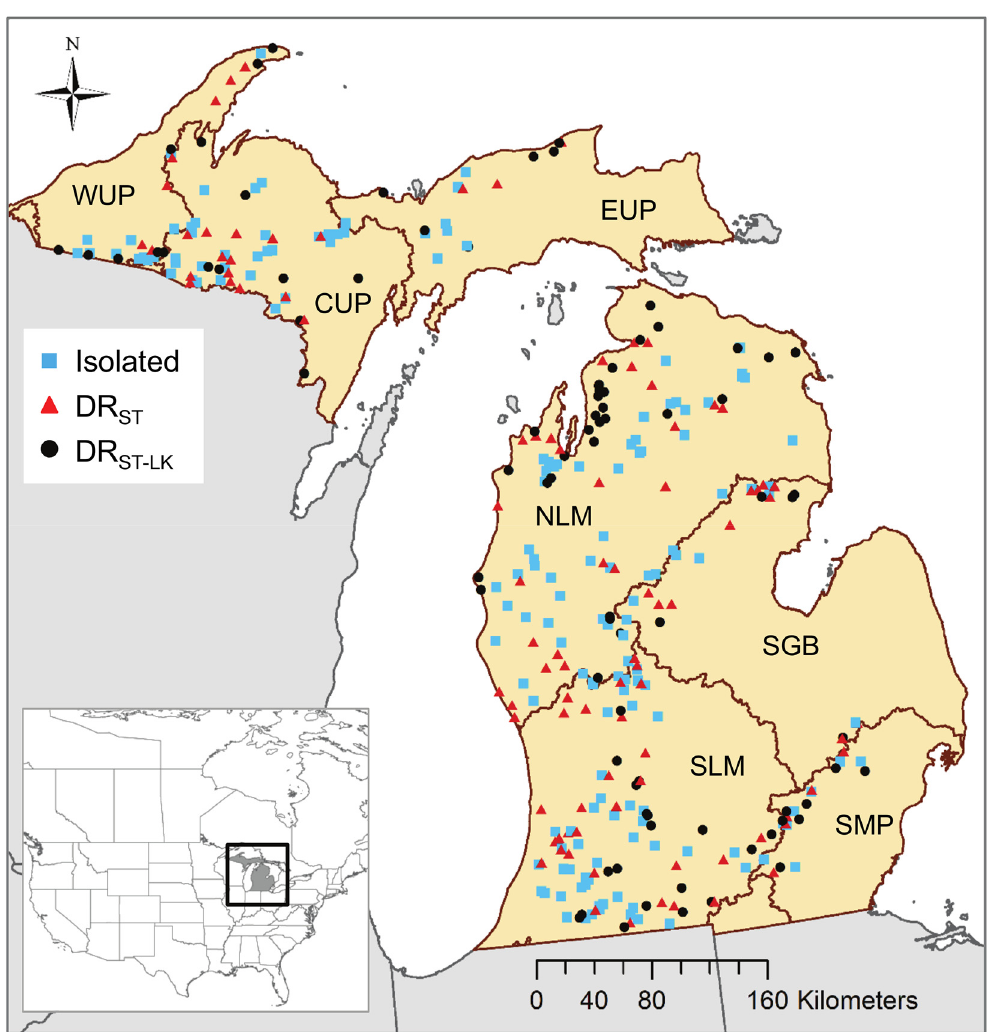
Fig 1. The location of the study lakes by lake class. The study area is Michigan USA and the map shows the regions used in all analyses (Ecological Drainage Units) delineated by brown lines within state boundaries delineated by grey lines. The 346 lakes are shown by lake hydrologic class (DR ST are drainage lakes with stream inflows; DR ST-LK are drainage lakes with stream inflows and at least one upstream lake (cid:1) 10 ha, see Fig 2 for details). The regions are labeled with a three-digit code as in Table 1. The inset shows the location of Michigan within North